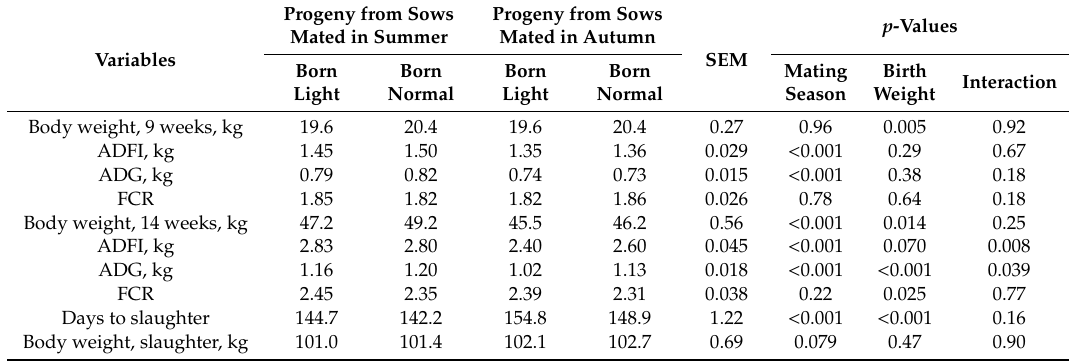
Table 4. Growth performance of focal progeny pigs born to sows mated in summer vs. autumn * . Variables Body weight, 9 weeks, kg